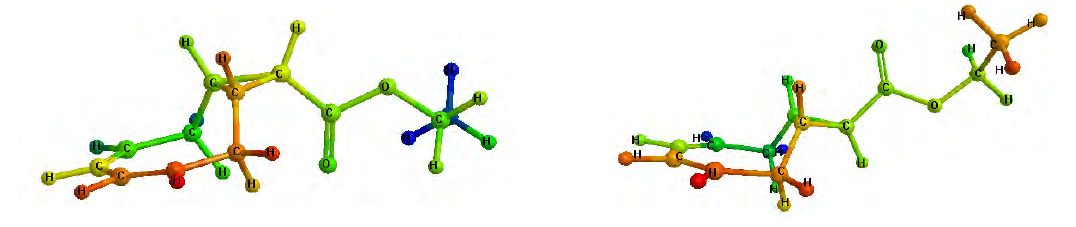
Figure 2. Minimized structures of 4a (left) and 4b